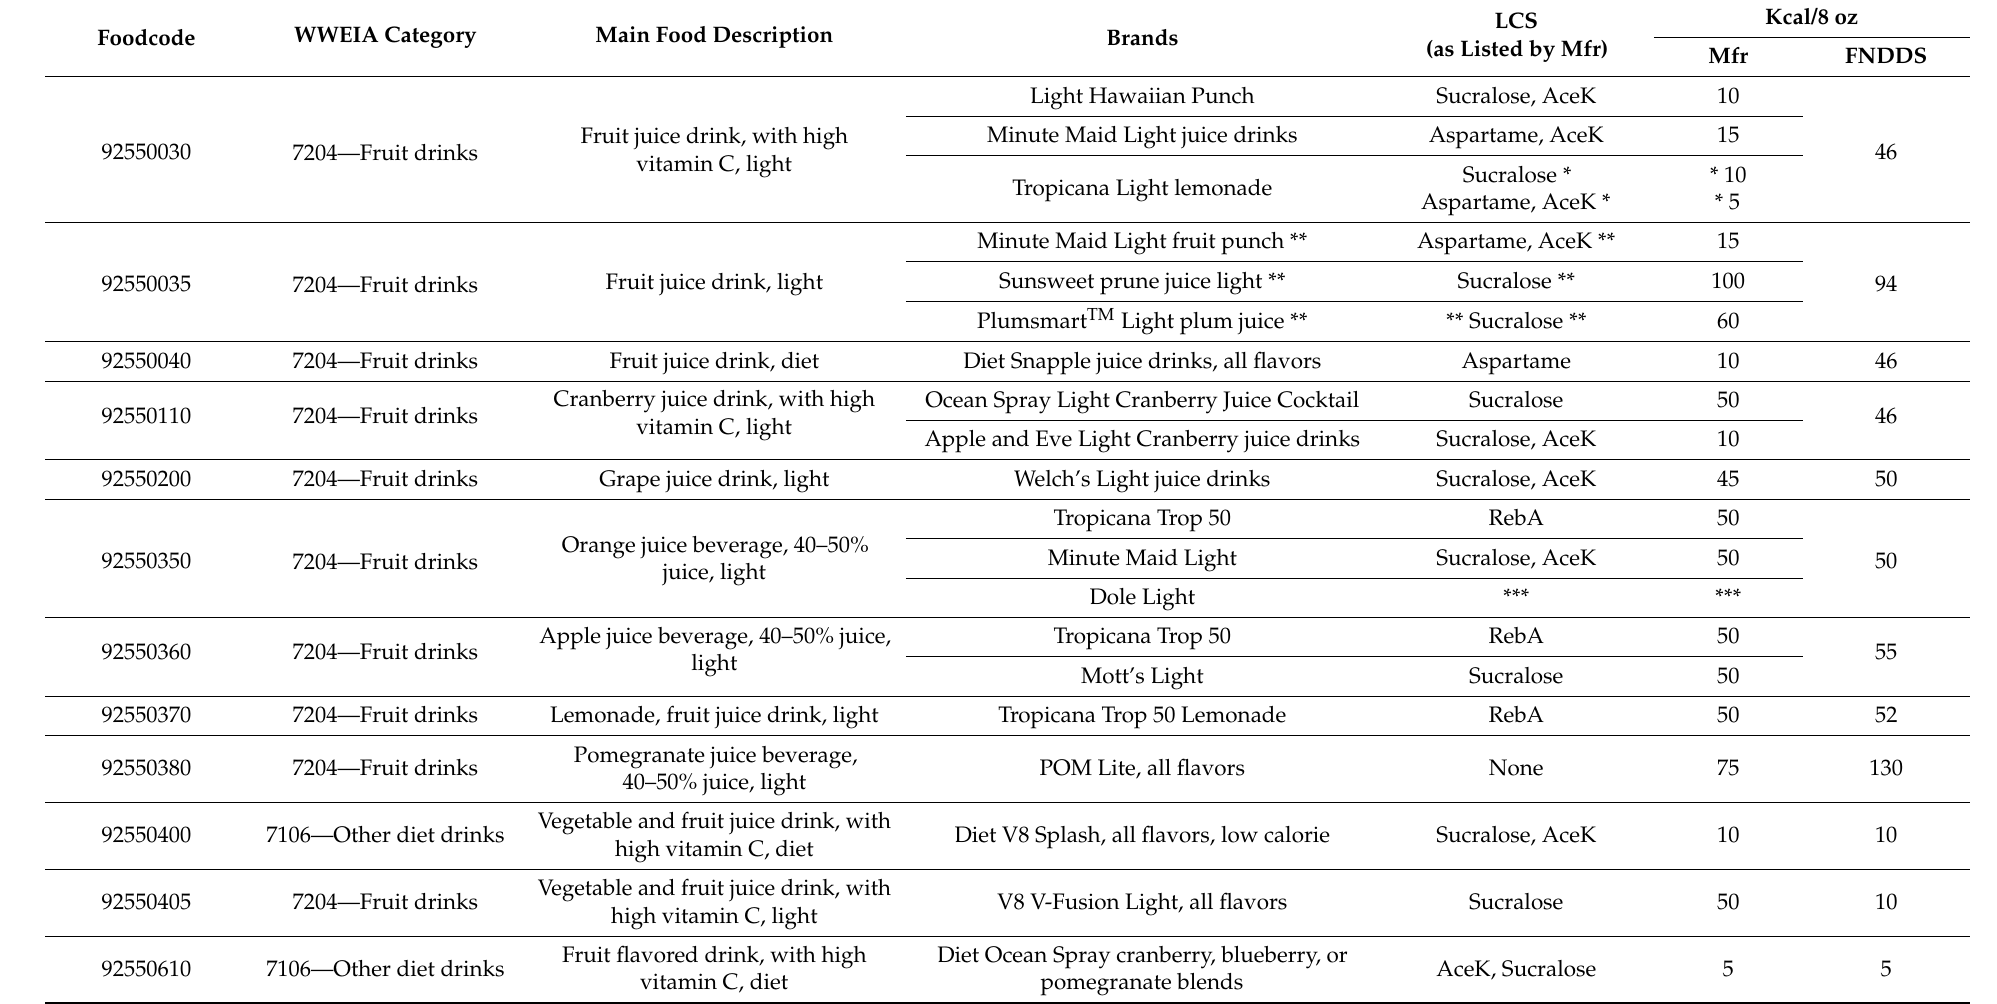
Table 2. Foodcodes in FNDDS category “Fruit juice drinks and fruit flavored drinks, low calorie”